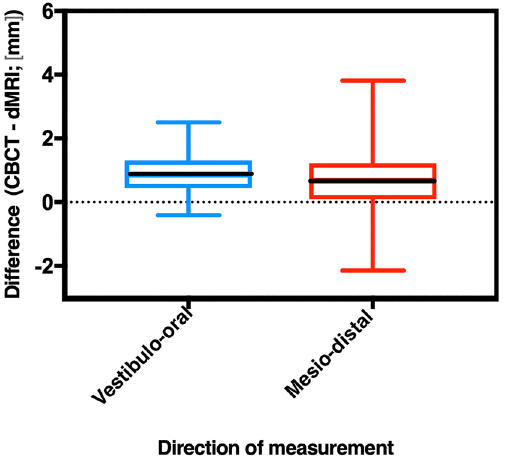
Figure 2. Box plots with 95% CIs of differences between dMRI and CBCT canal length measurements. The bold black line represents the median differences.